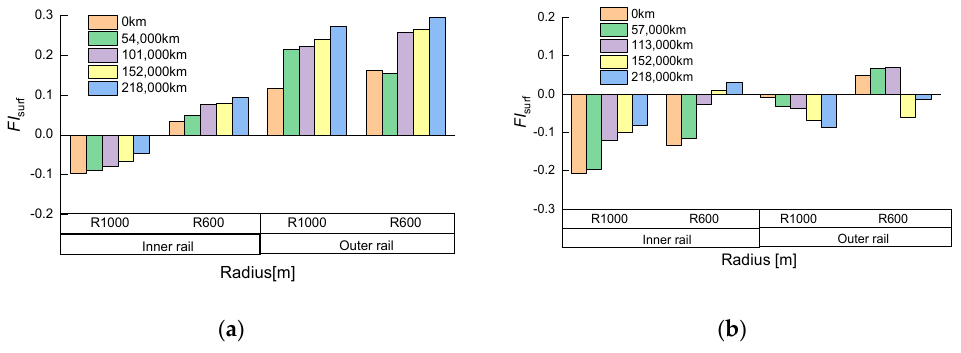
Figure 15. Rolling contact fatigue index: ( a ) Line A; ( b ) Line B.